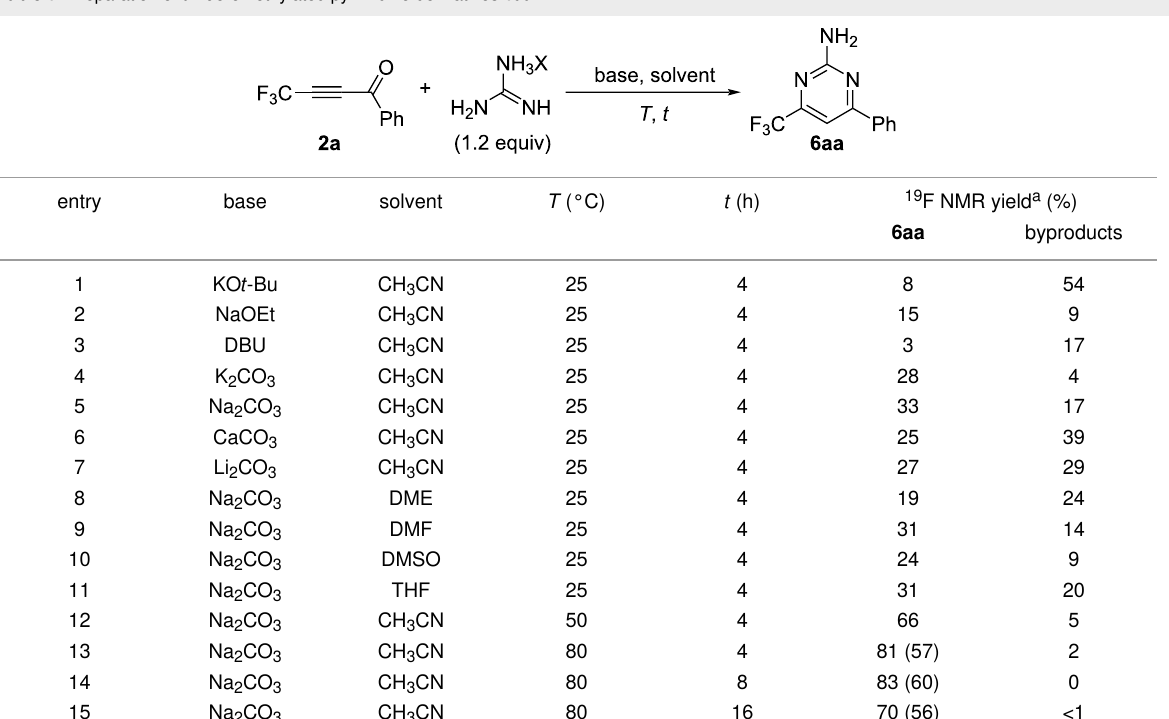
Table 5: Preparation of trifluoromethylated pyrimidine derivatives 6aa .